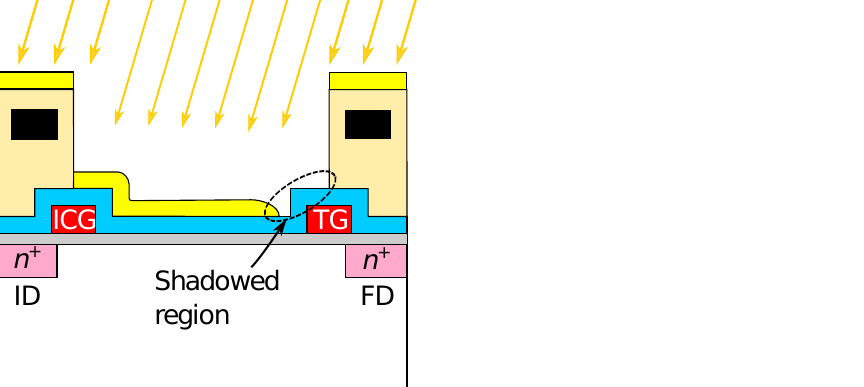
Figure 6. Schematic illustration of shadowing effect during evaporation of gold